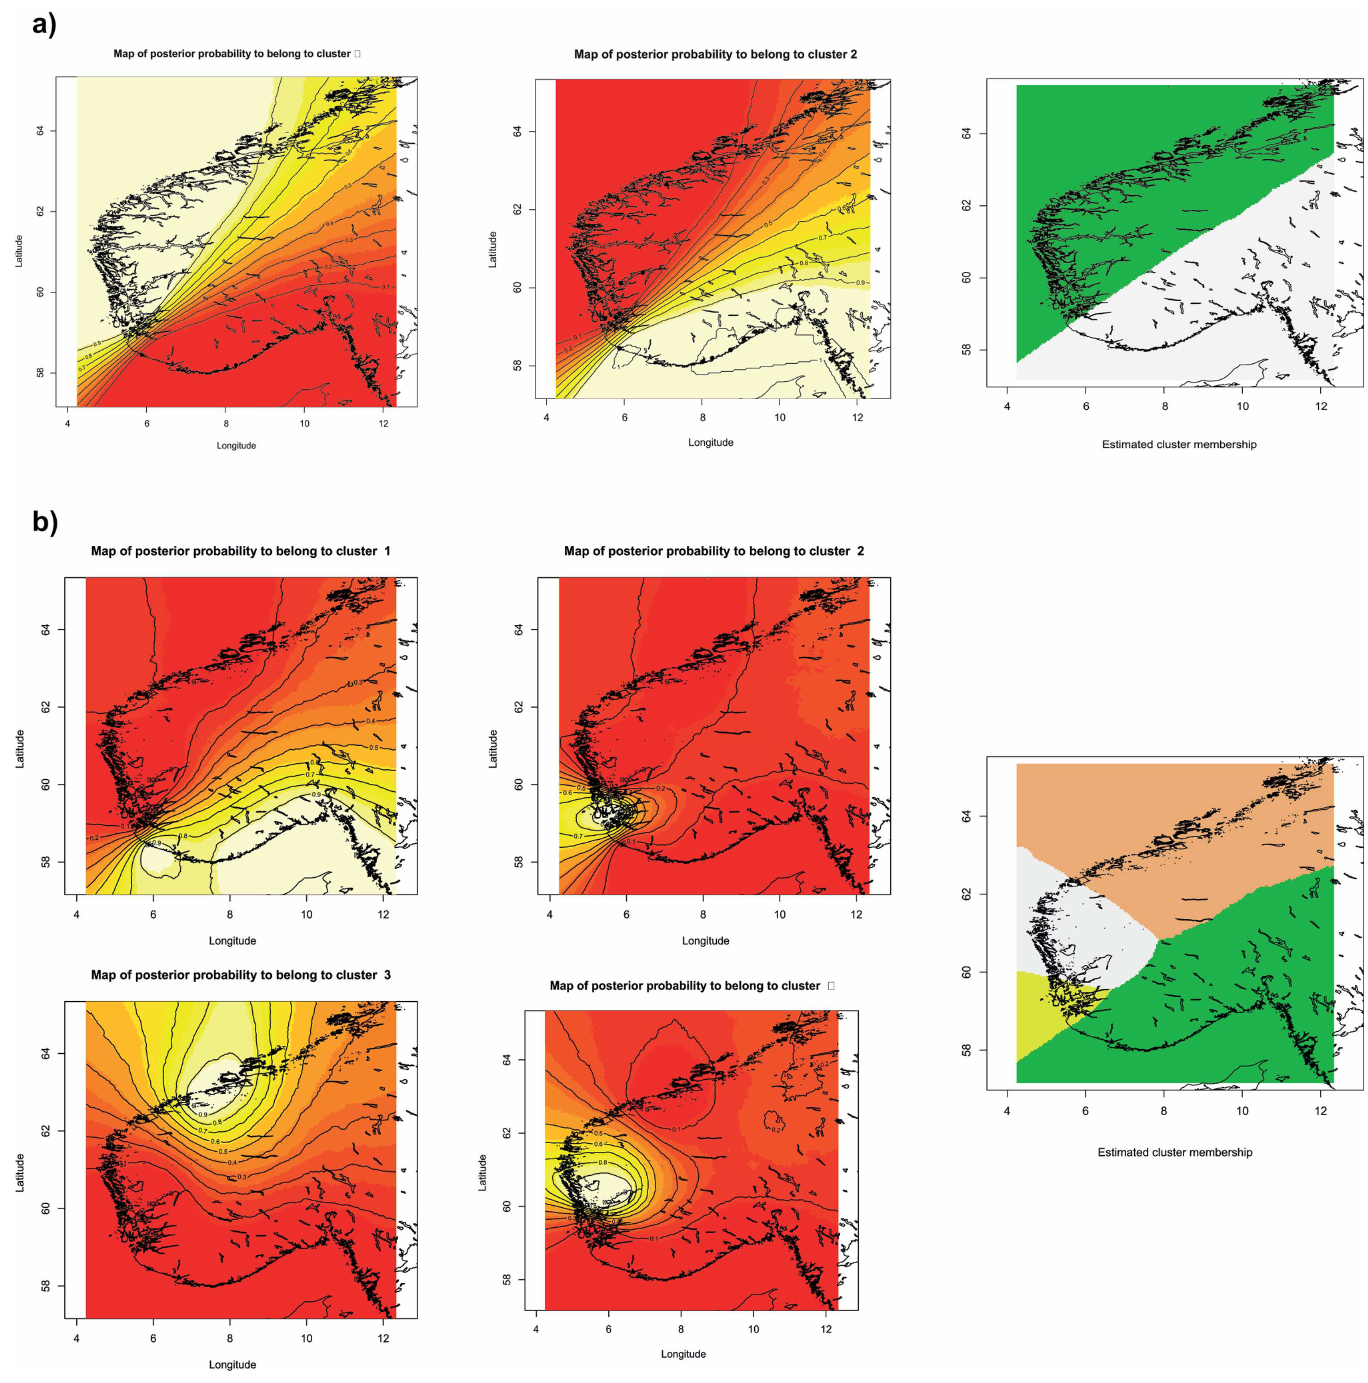
Fig 2. Maps of posteriorprobabilities of corkwingwrasse individualmembership definedby GENELANDundera) uncorrelated ( K = 2) and b) correlated ( K = 4) alleles model.Plots representing assignmentof pixels to each cluster(highest probabilityin light yellow and zero probabilityin red) and map of estimatedposteriorprobabilityof population membership are presentedfor each